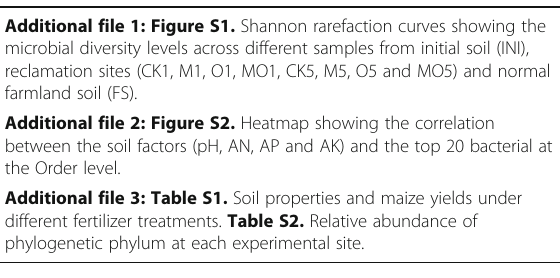
Additional file 1: Figure S1. Shannon rarefaction curves showing the microbial diversity levels across different samples from initial soil (INI), reclamation sites (CK1, M1, O1, MO1, CK5, M5, O5 and MO5) and normal farmland soil (FS). Additional file 2: Figure S2. Heatmap showing the correlation between the soil factors (pH, AN, AP and AK) and the top 20 bacterial at the Order level. Additional file 3: Table S1. Soil properties and maize yields under different fertilizer treatments. Table S2. Relative abundance of phylogenetic phylum at each experimental site.